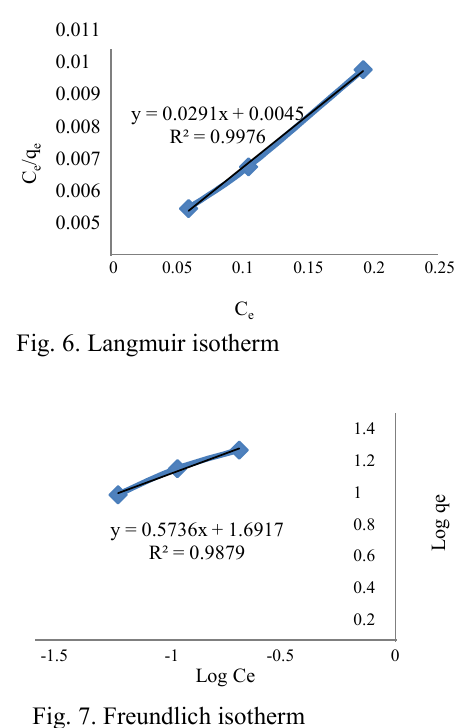
Table 1. Isotherm constants for copper ion removal by magnetic nanoparticles Langmuir isotherm Freundlich isotherm Temkin isotherm q m